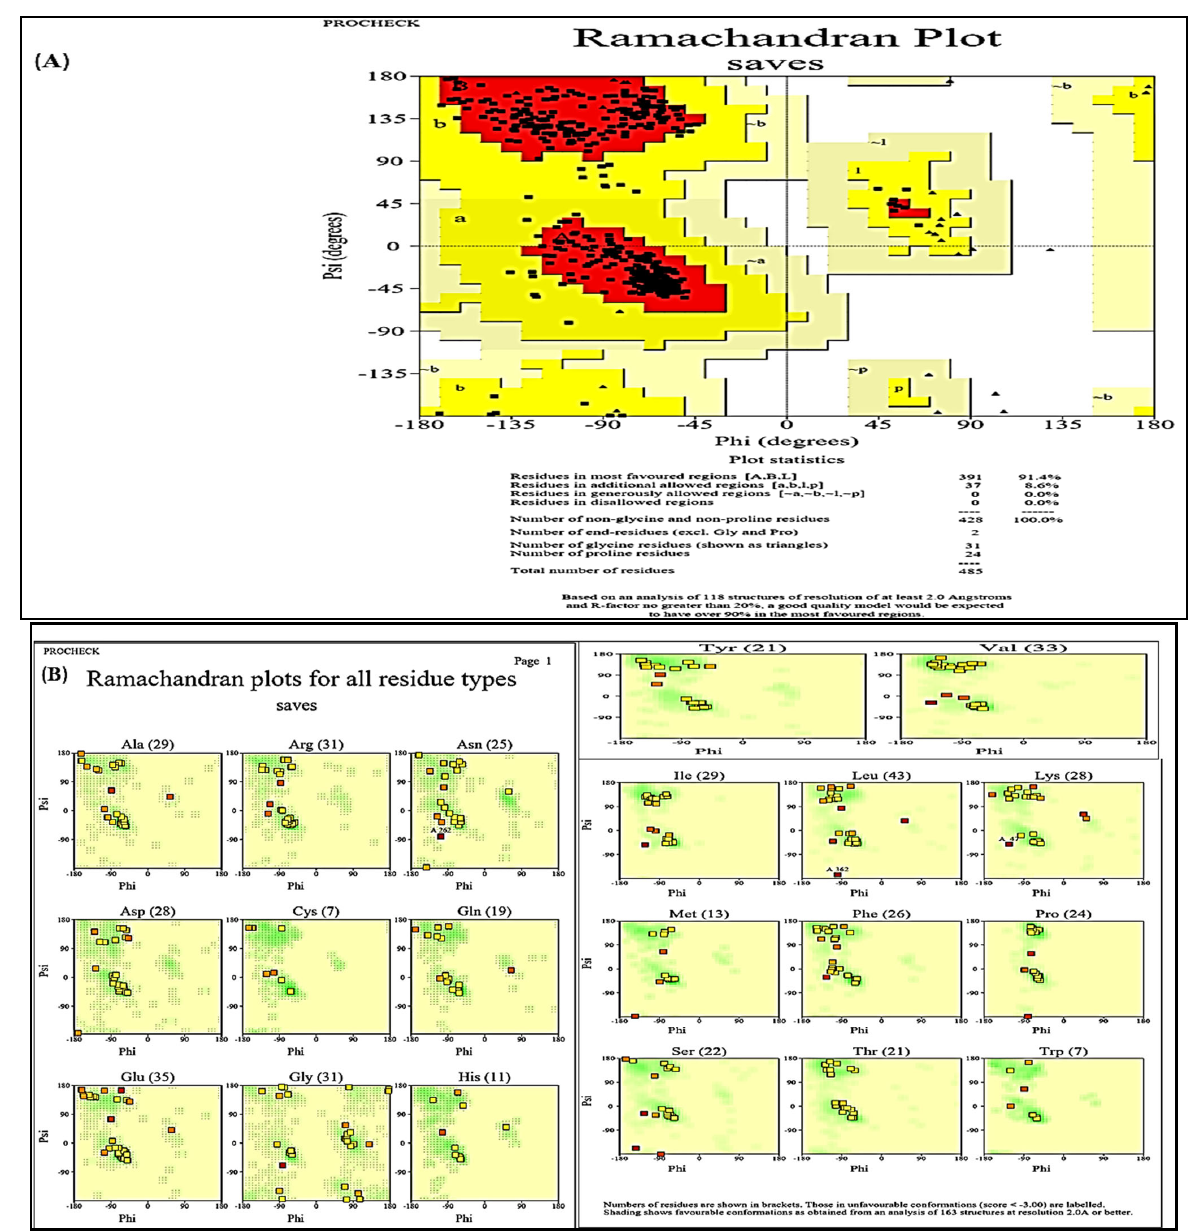
Figure 5. PROCHECK analysis of Ramachandran plot with ( A ) Plot statistics and ( B ) All